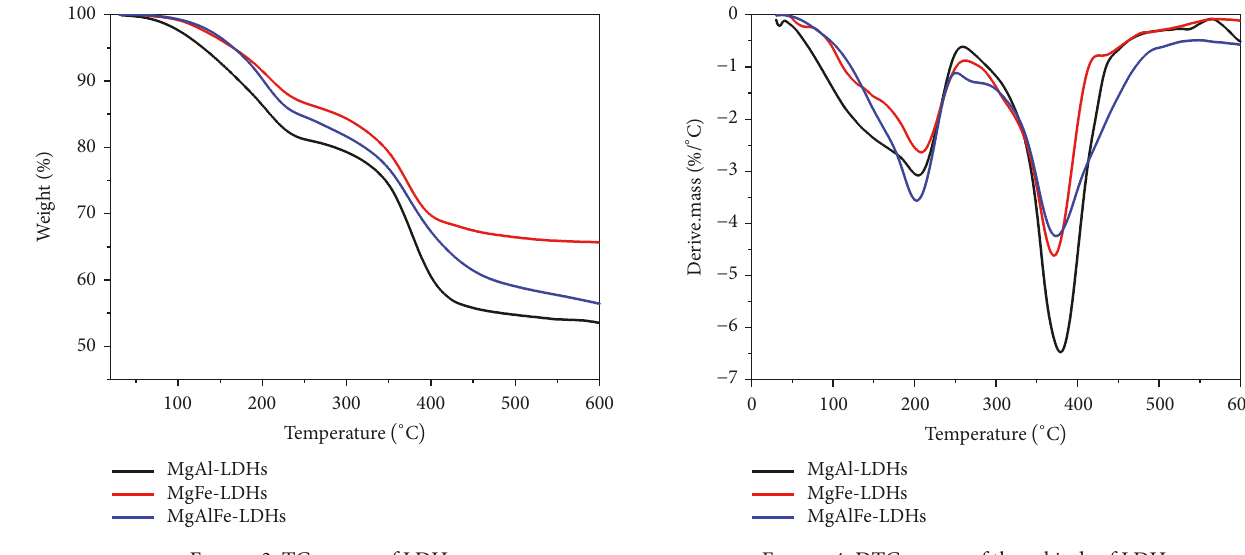
Figure 3: TG curves of LDHs. Figure 4: DTG curves of three kinds of